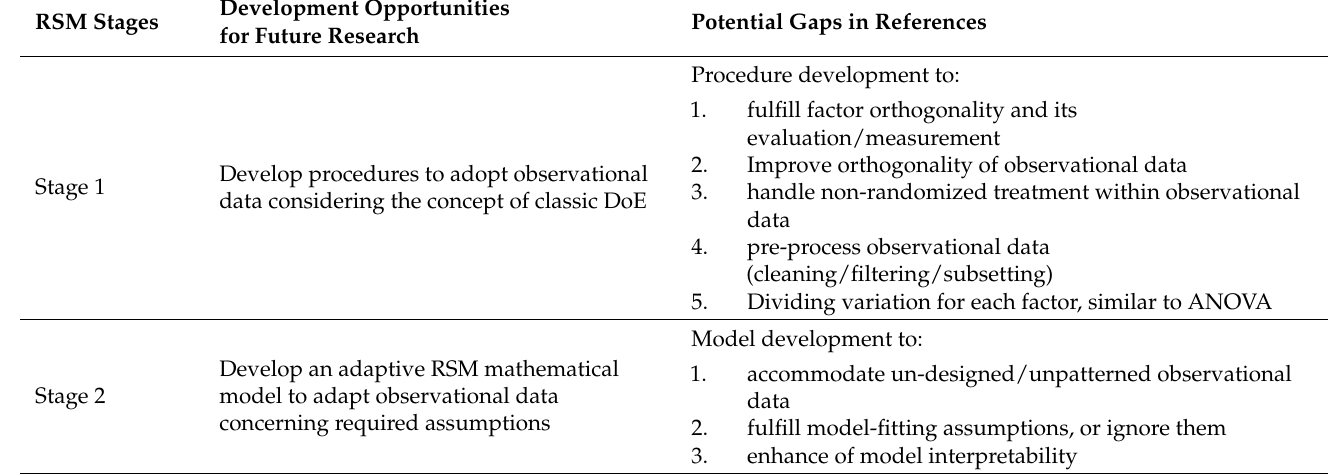
Table 8. Opportunities and gaps for further